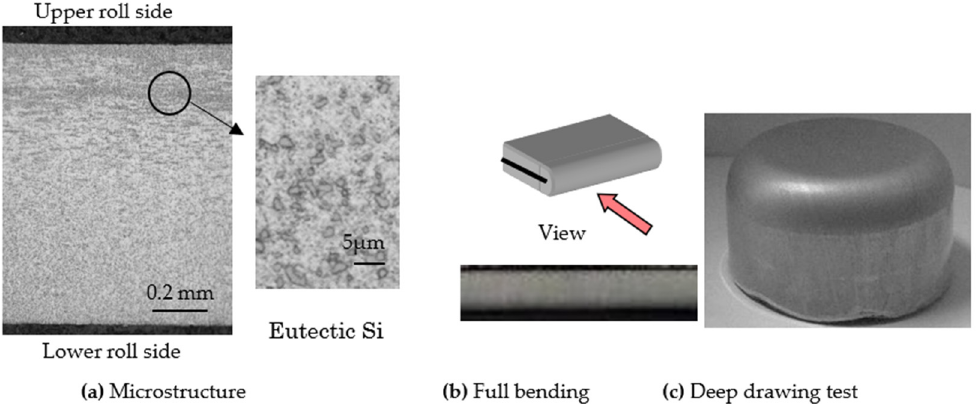
Figure 17. Eutectic Si, full bending and deep drawing of roll cast A356. ( a ) Cross section of cold rolled 1-mm-thick strip and its eutectic Si, ( b ) Outer surface of full bent cold-rolled and annealed 1-mm-thick strip. ( c ) Deep drawing of cold rolled and annealed 1 mm thick strip. Punch diameter was 32 mm and blank holder pressure was 1.2 kN.